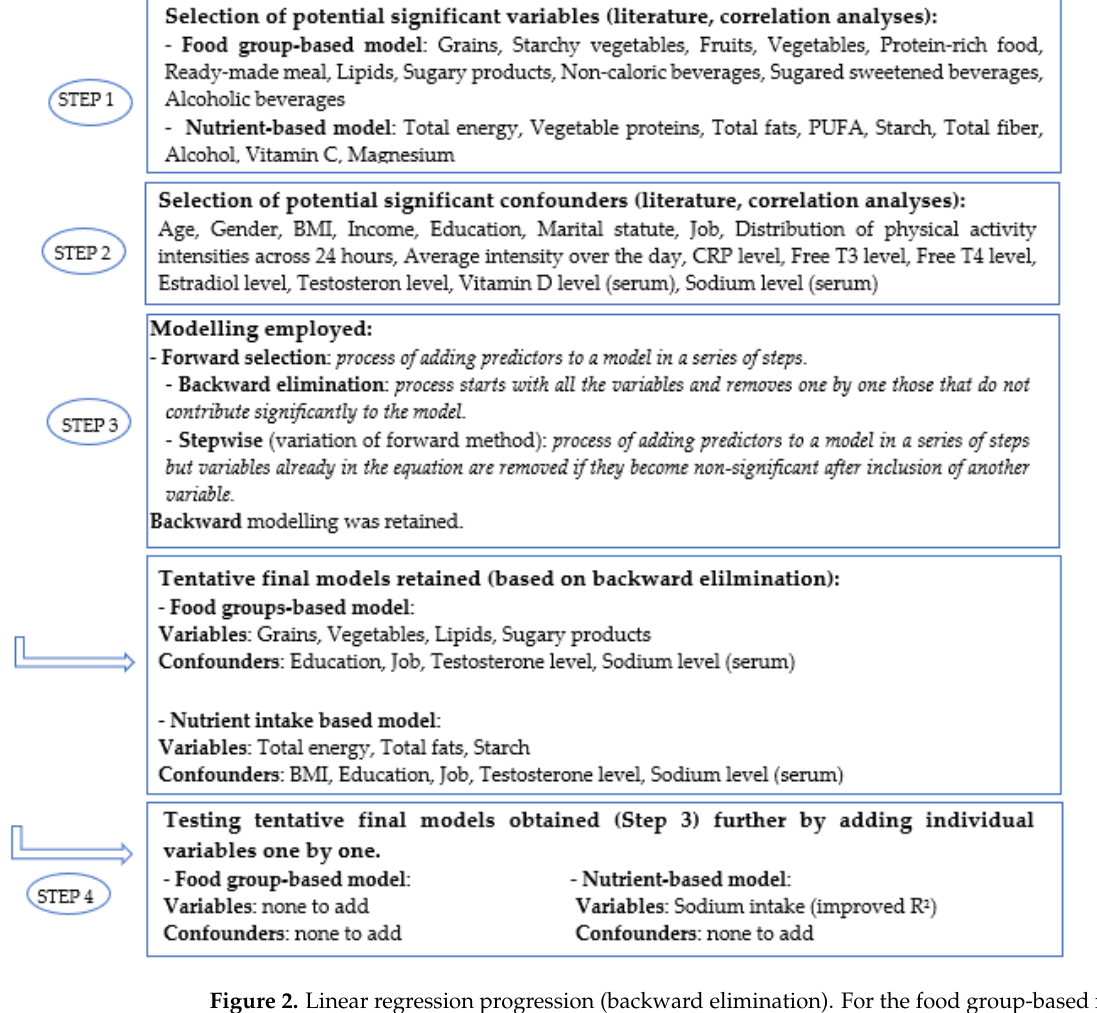
of the food groups. Variables retained in the final model were grains, vegetables, lipids, and sugary products, and retained confounders were education level, job, testosterone serum level, and sodium serum